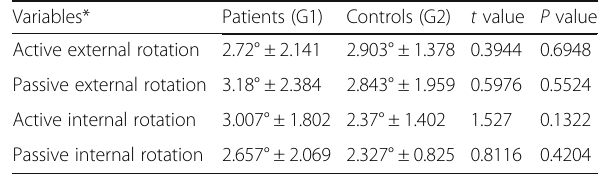
Table 4 Comparison of angular displacement errors of shoulder joint position sense in the unaffected arm of patients (G1) and dominant arm of normal subject (G2) Variables* Patients (G1) Controls (G2) t value P value Active external rotation 2.72° ± 2.141